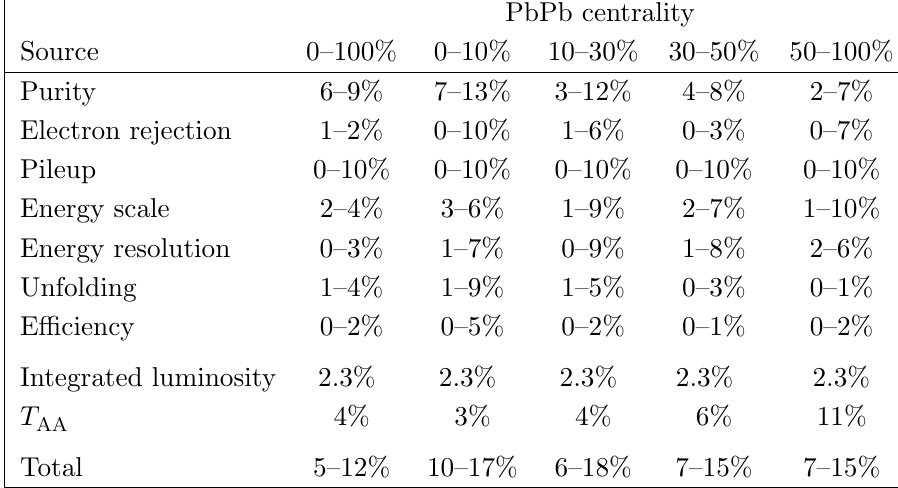
Table 3 . Summary of the contributions from various sources to the estimated systematic uncer- tainties in the nuclear modi(cid:12)cation factors calculated from pp and PbPb data. When ranges are shown, they indicate the E g -dependent variations of the T